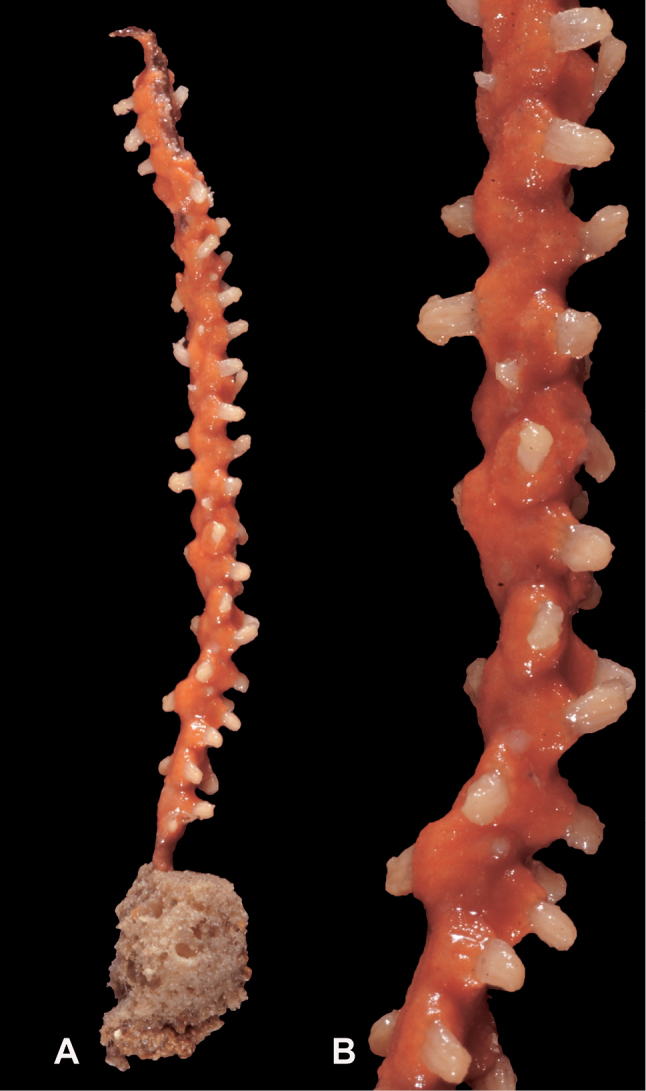
Chromoplexauramarki, SBMNH 265948. A Very small colony, 4.0 cm in length, excluding mass at base, which appears to be a sponge. Sclerites did not always consistently match sclerites seen in the species, illustrating variable nature of sclerite forms B Close up of extended polyps on single branch, each measuring ≤ 1.0 mm in height.